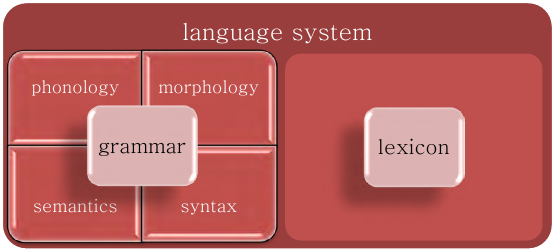
Figure 1: Structure of the language system (cf. Neef 2005: